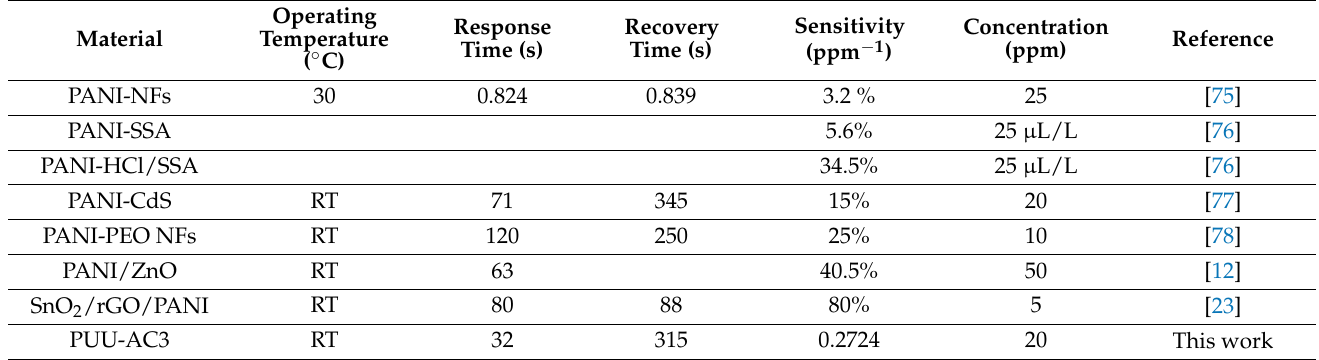
Table 2. Comparison of H 2 S-gas sensors, based on conductive polyaniline and composites.